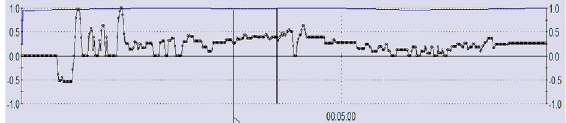
Fig. 13. Hydrodynamic influence between the PANAMAX tanker and a ferry expressed as rudder rotation in the narrow channel in the parallel direction (vertical line in the figure corresponds to the ship position indicated in Fig. 12)